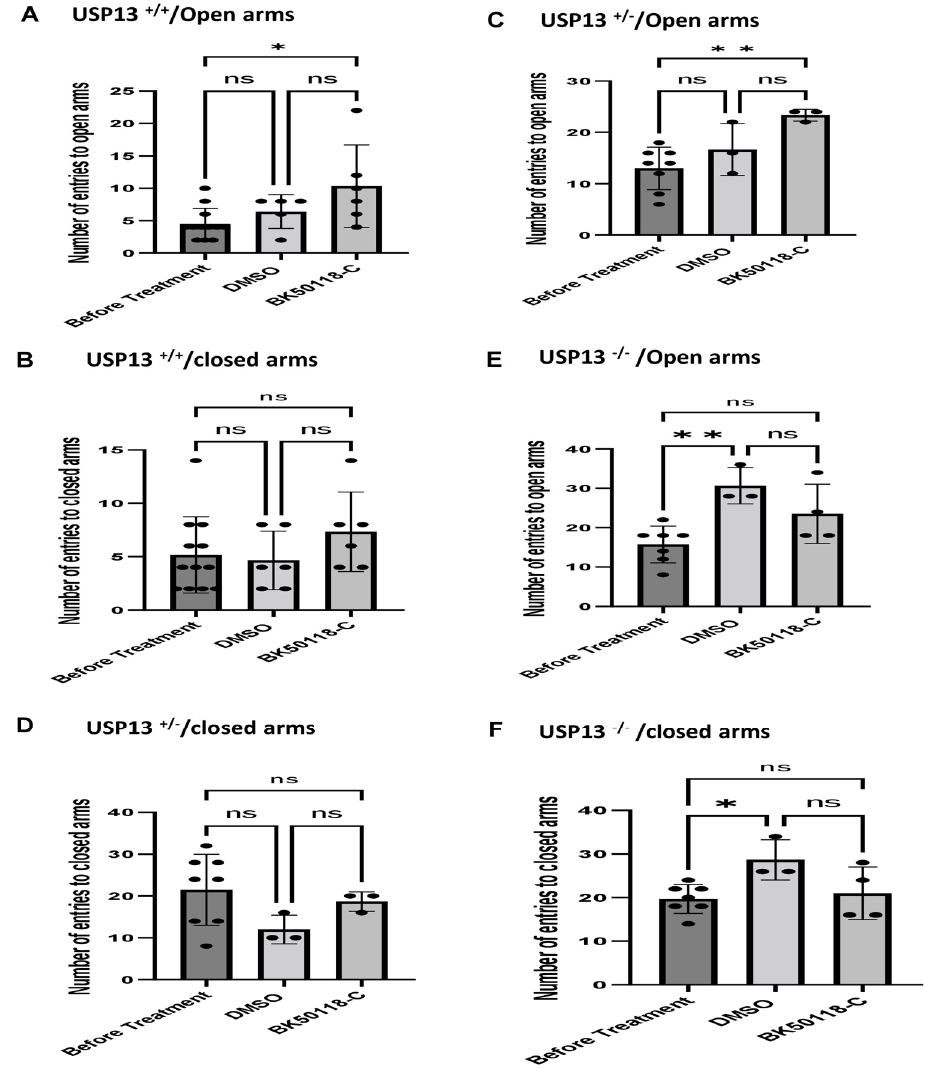
Figure 4. BK50118-C reduces anxiety in USP +/+ and USP +/ − but not in USP13 − / − mice stressed with alpha-synuclein. Elevated plus maze test showed that BK50118-C increased number of entries to open arms in ( A ) USP+/+ and ( C ) USP +/ − mice, but not in number of entries to closed arms ( B , D ). BK50118-C had no significant effects on the number of entries to either open ( E ) or closed ( F ) arms in USP13 − / − mice. The asterisk indicates statistically significant difference. One-way ANOVA, non parametric test. * p < 0.05, ** p < 0.01. n = 3–12 per group. Mean ± SD. The black dot • represents each individual data. ns: no